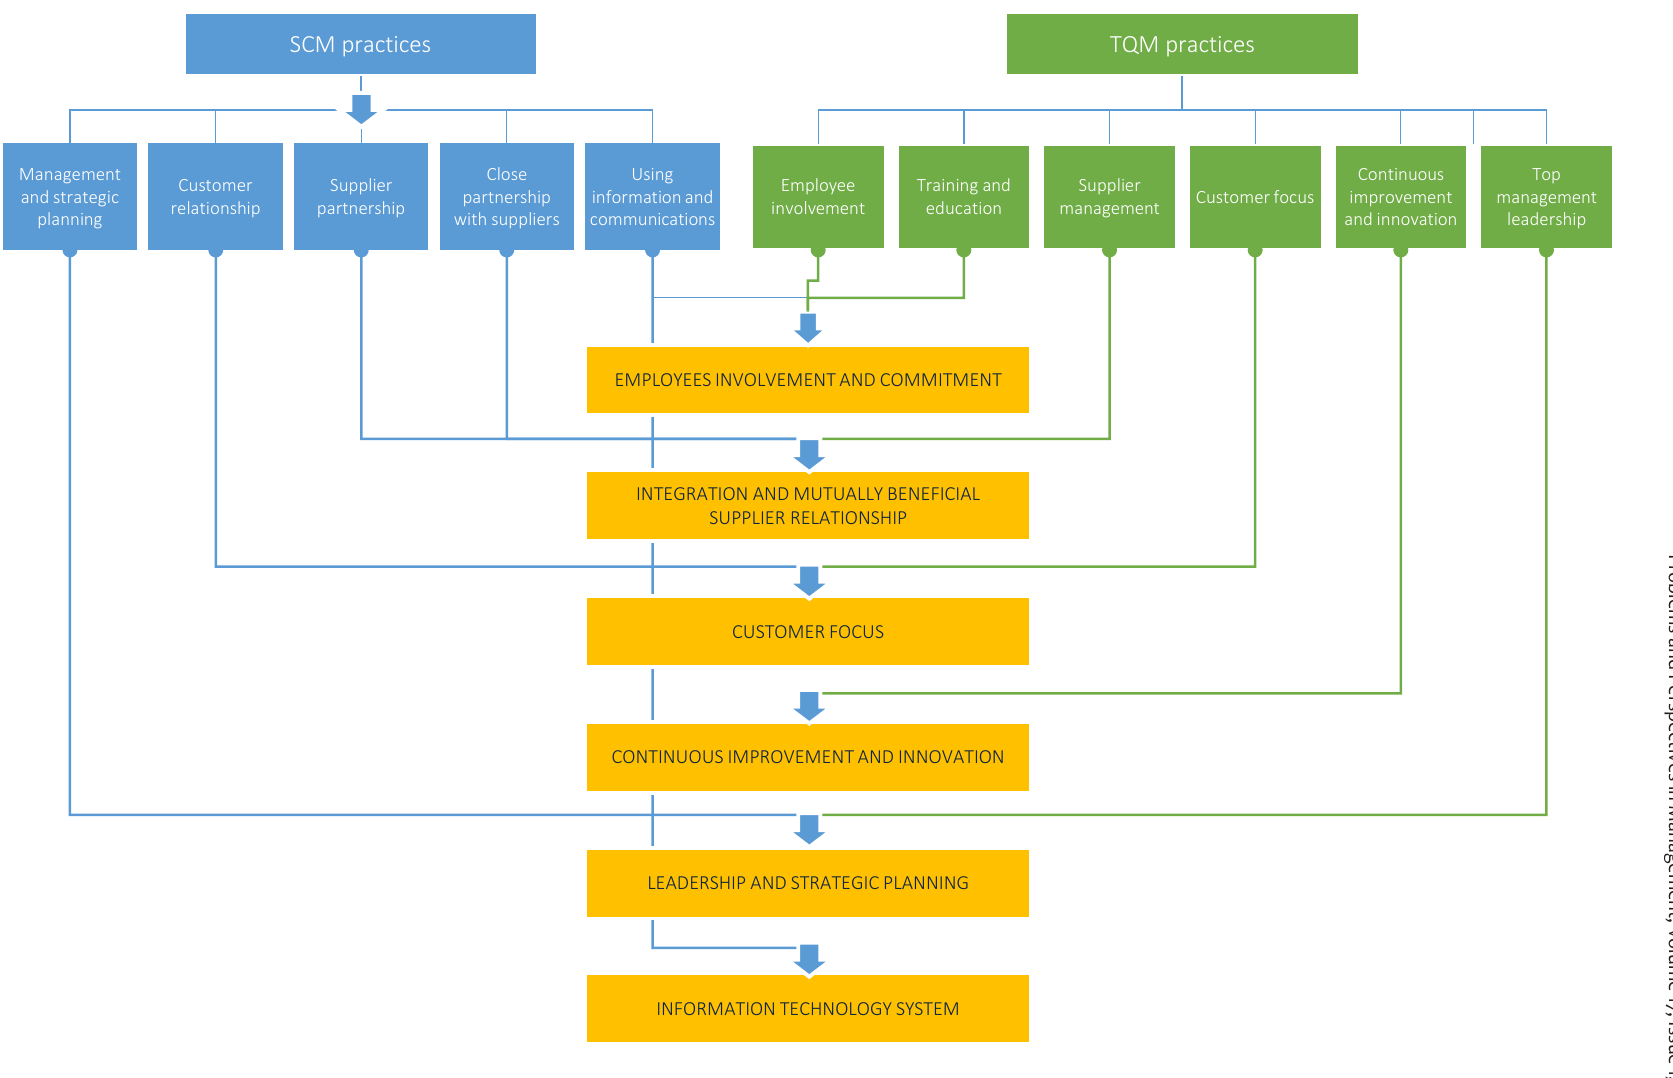
Figure 1. Conceptual